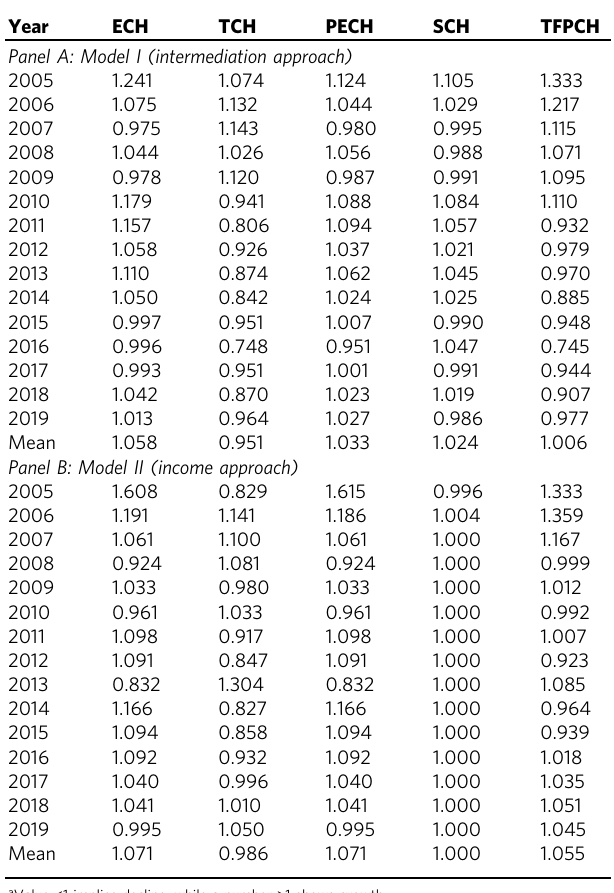
Table 2 Total factor productivity change (summary of annual means) a,b